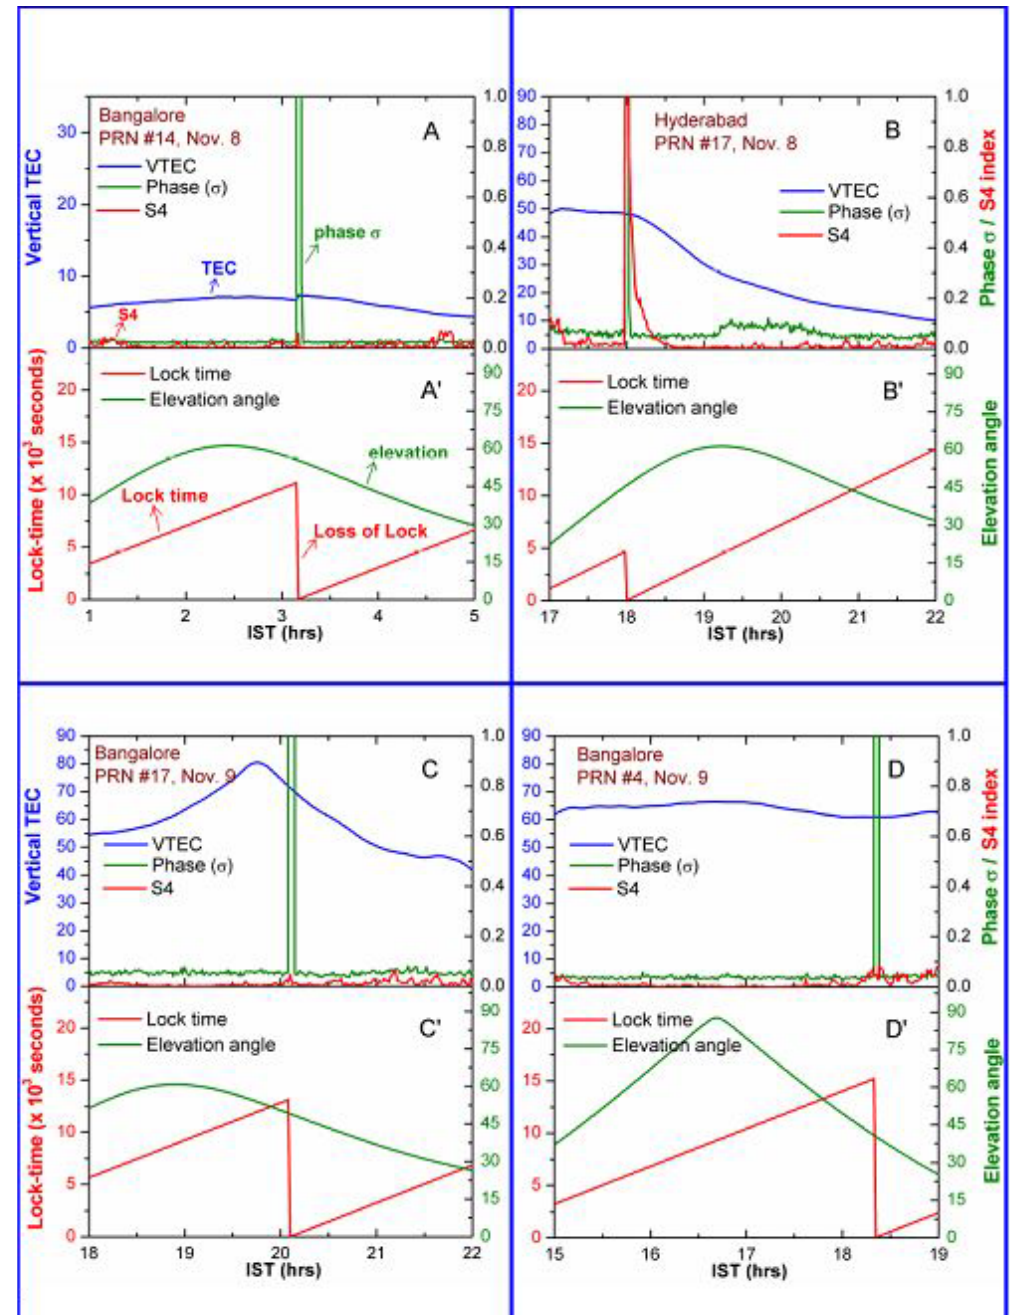
Fig. 5. Phase slips resulting in loss of locks during the geomagnetic storm period of 8 and 9 November 2004, presented along with the corresponding S4 index, TEC and lock time on different satellite passes at different